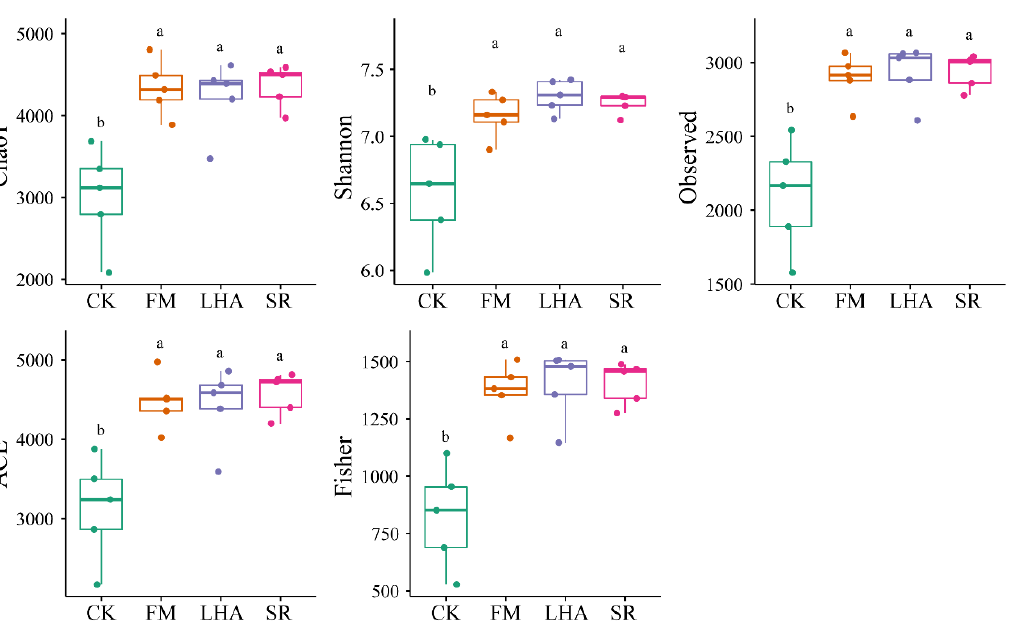
Figure 4. Bacterial alpha diversity in the soils in the different treatments. Different letters represent significant difference ( p < 0.05) by LSD test.